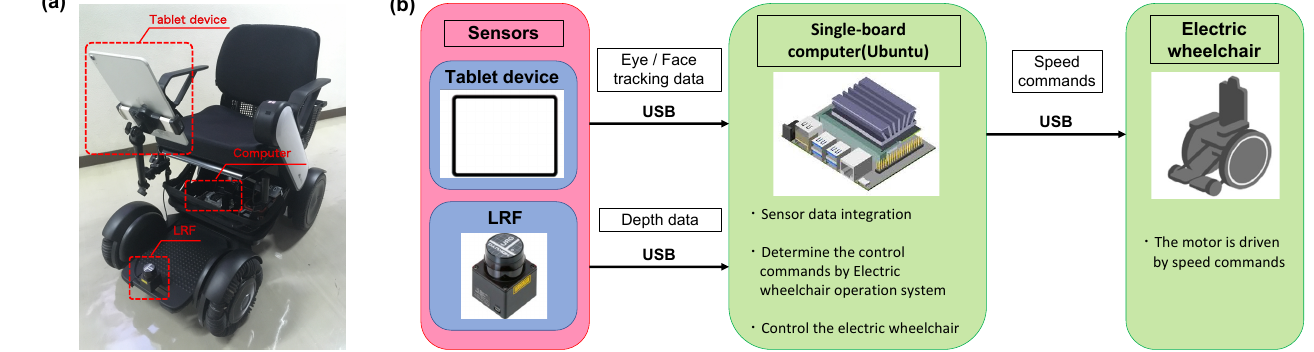
Figure 1. Structure of the eye-controlled electric wheelchair: ( a ) Appearance of the WHILL; ( b ) System components.